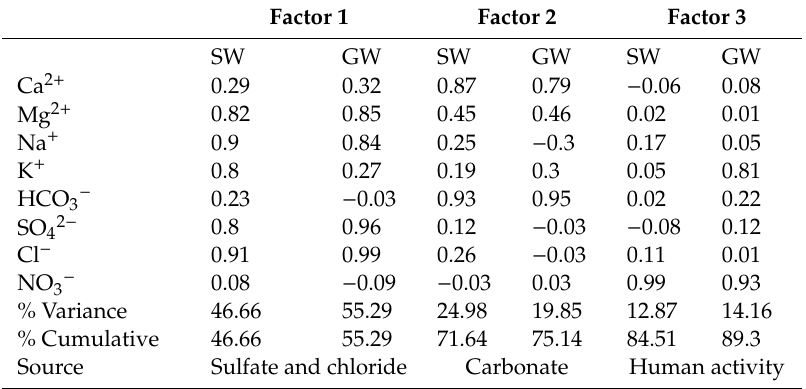
Table 4. Results of principal component analysis for major ions in stream water and